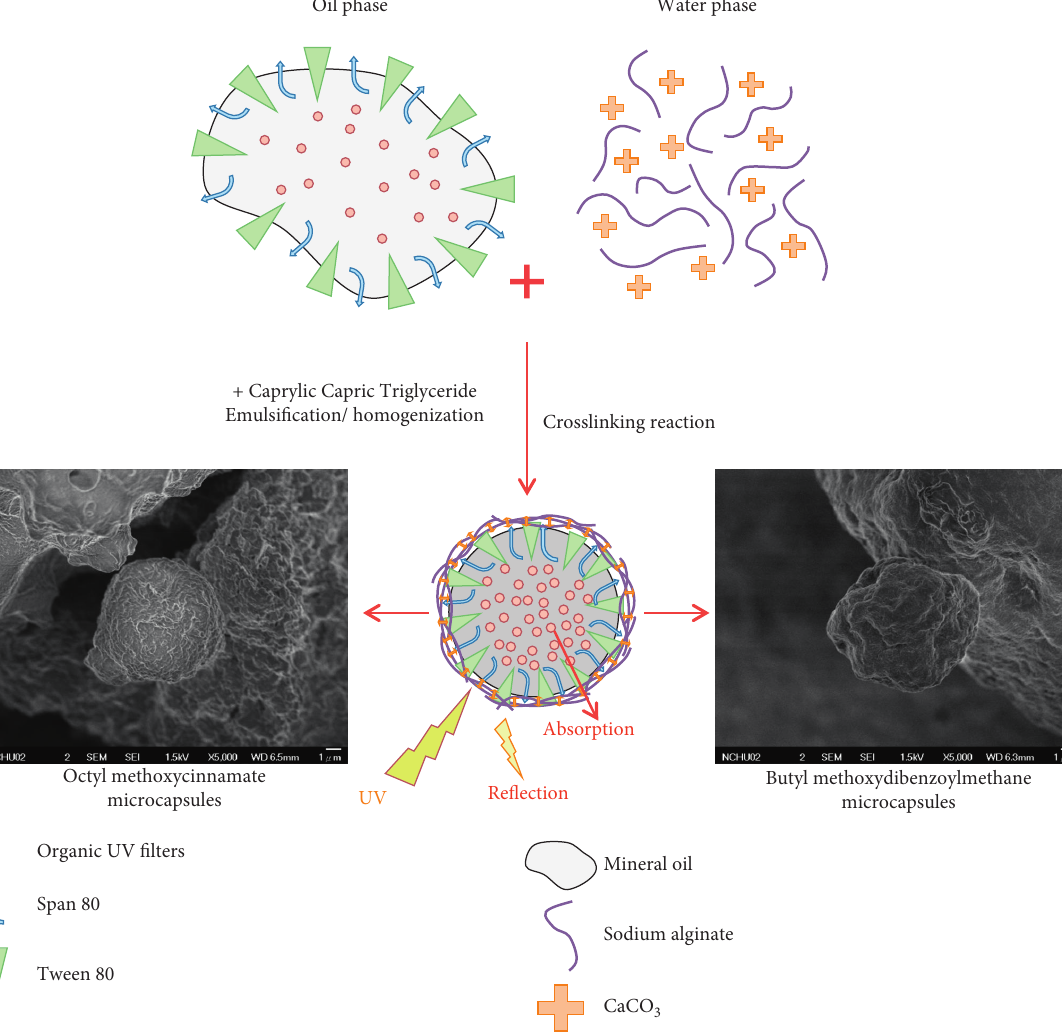
Figure 5: Illustration of the composite UV filter microcapsules in this